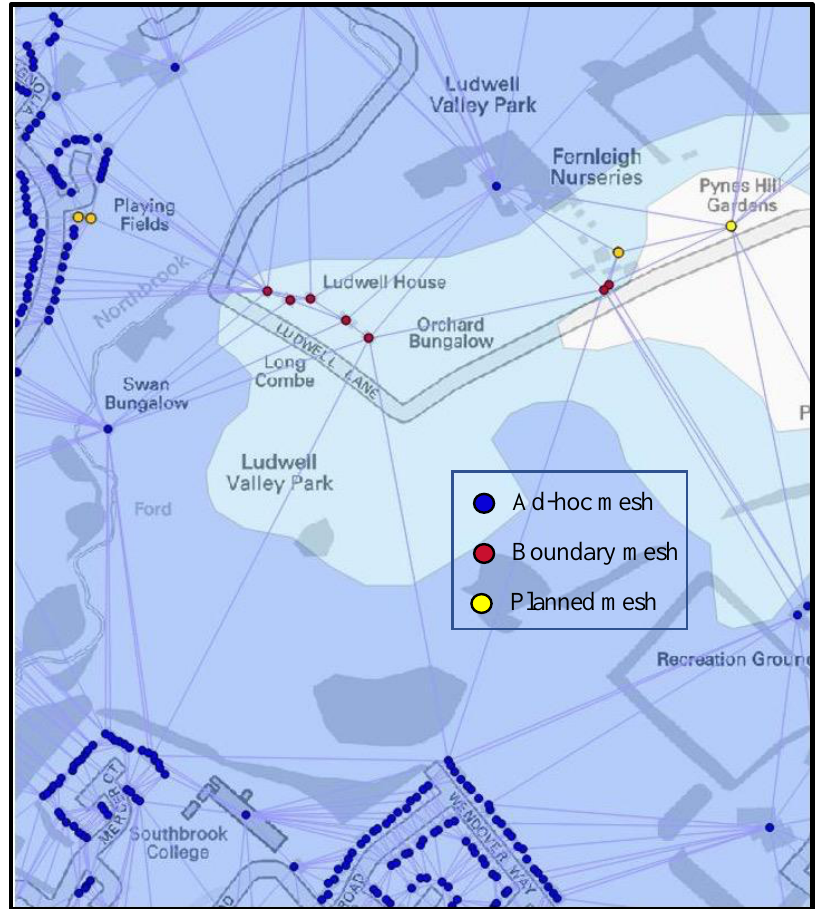
Figure 8. The complexity of the structure of the mesh networks.